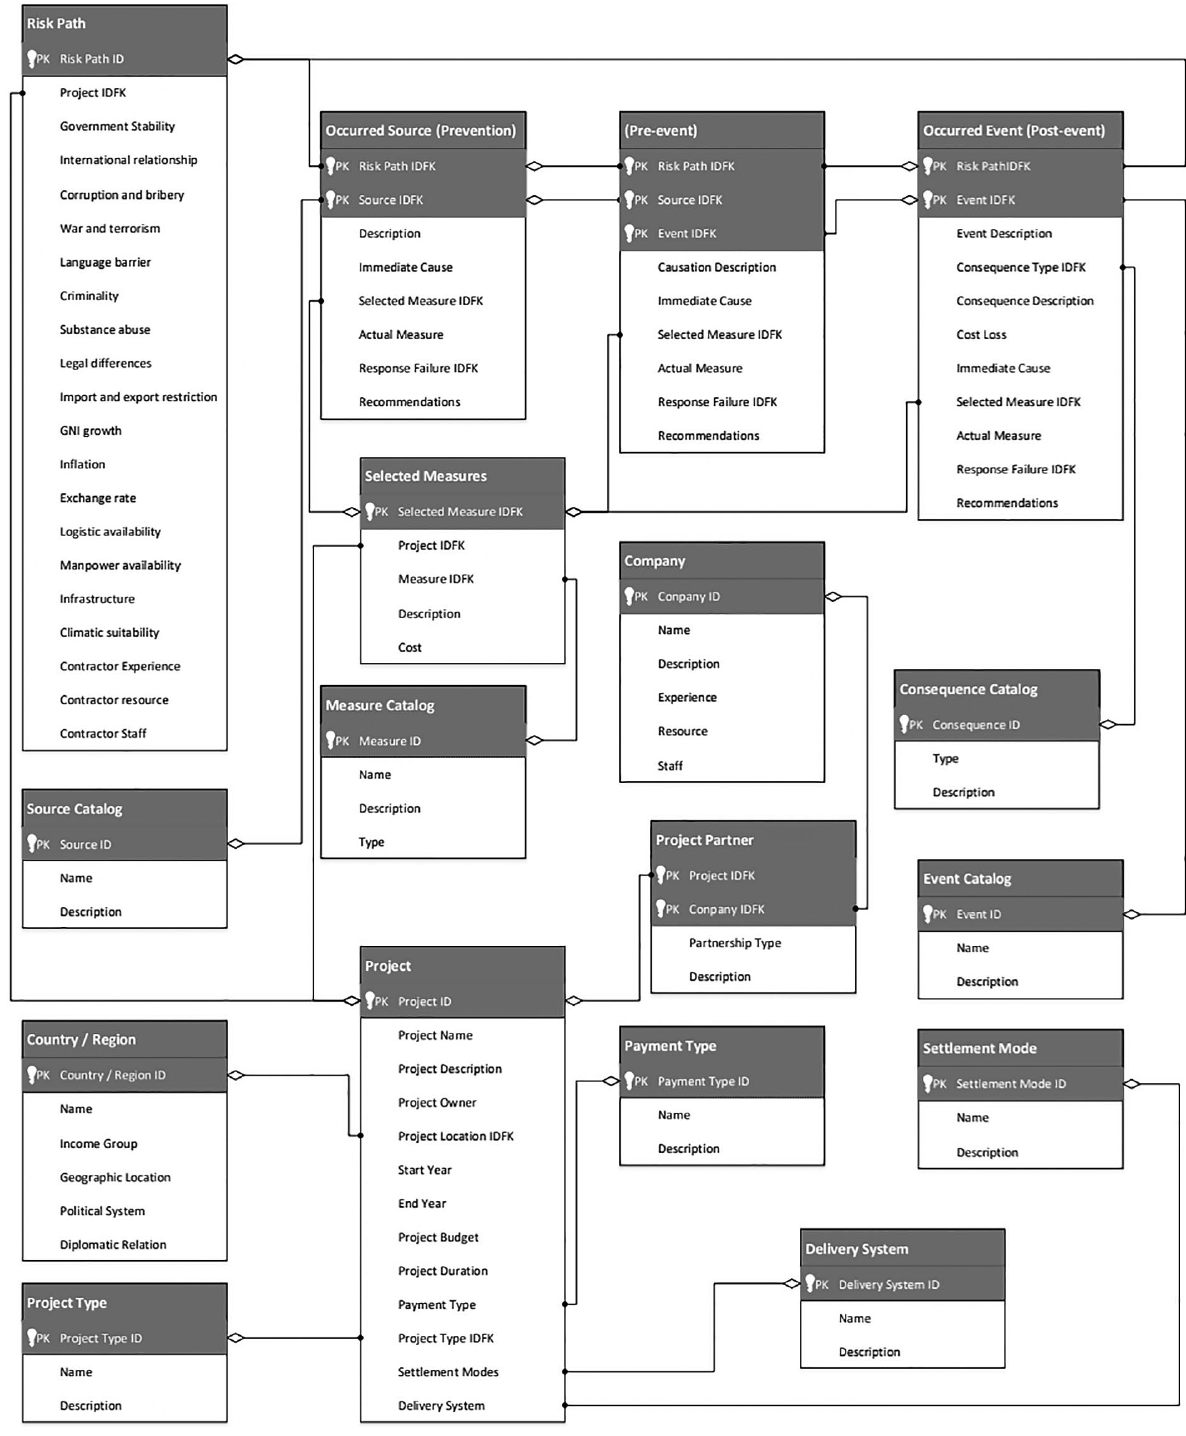
Figure 5. Embedded RCM_ICP in the structure of the company’s risk